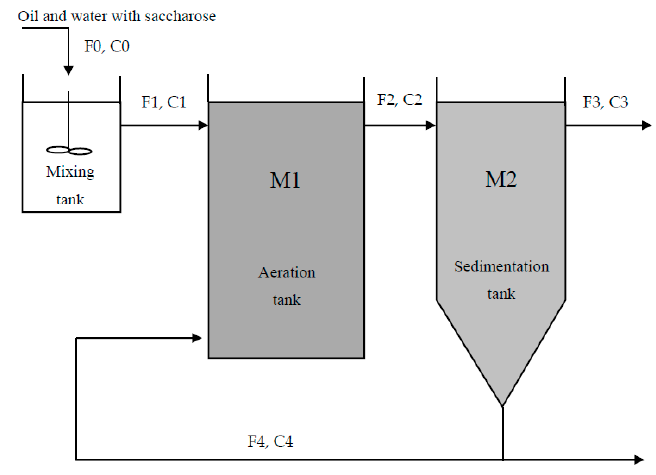
Figure 4. The plant process of activated sludge diagram.